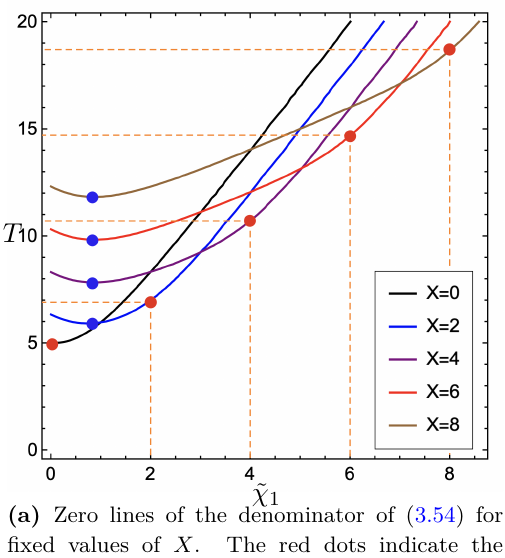
Figure 6. Curves along which the denominator of (3.54) vanishes. Here, we consider a perturbation localized at χ 0 = 0 and t 0 = 0 , and we set d = 3 , ∆ O = 1 . 4 and G N = 1